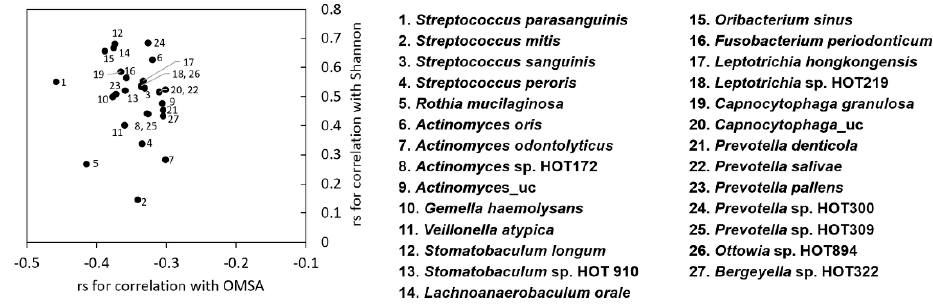
Figure 5. Species negatively associated with the severity of oral mucositis. Correlations of the relative abundance of each species with the OMAS score and Shannon index were analyzed by the Spearman’s rank correlation test. Twenty-seven species, the relative abundance of which showed non-negligible correlations (r s ≥ | 0.3 | , p ≤ 0.004) with OMAS scores, were chosen. The graph presents the coefficients for correlation with OMAS and those for correlation with the Shannon index.